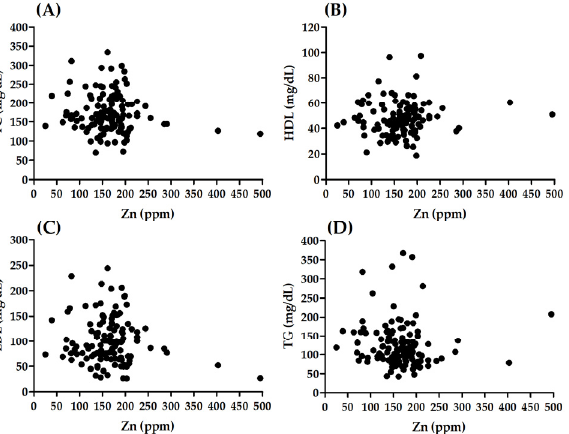
Figure 4. Correlation between Zn level and lipid profile: ( A ) TC, ( B ) HDL, ( C ) LDL, ( D ) TG.